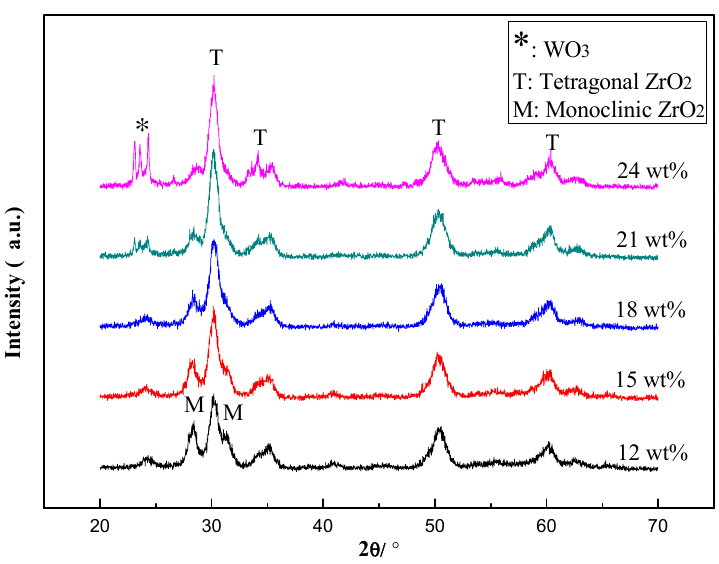
Figure 4. XRD patterns of the Cr-Pt/WZ catalysts with different WO 3 contents.